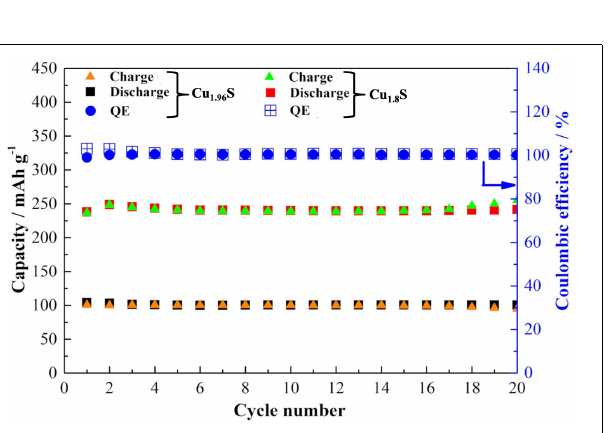
FIGURE 7 | Cycle performance of Cu 1 . 96 S (90 ◦ C, 10 s) and Cu 1 . 8 S (90 ◦ C, 1 min) cathodes between 1.0 and 3.0 V at C/5 over 20